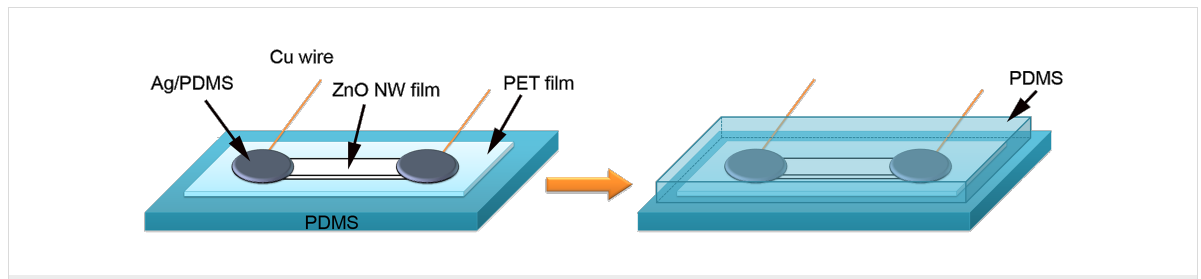
Figure 6: Illustration for the device fabrication